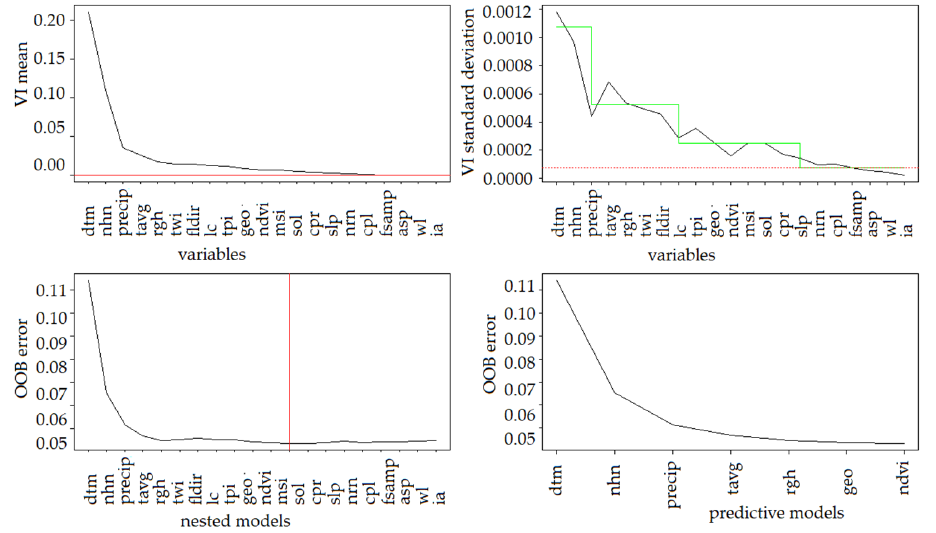
Figure 4. HG-PT variables of importance, NB. Upper left , mean variable importance, upper right : standard deviation of the variable importance, bottom left : mean OOB error rate of interpretation step of RF models, bottom right : mean OOB error rate of prediction step of RF models. Red lines indicate thresholds. The green line represents predictions given by a CART tree fitted to standard deviations.